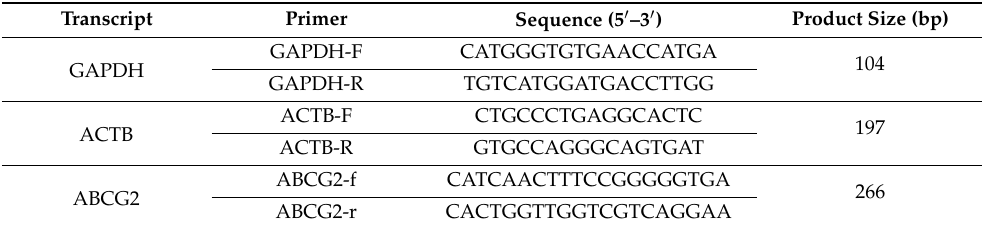
Table 1. Primers used for